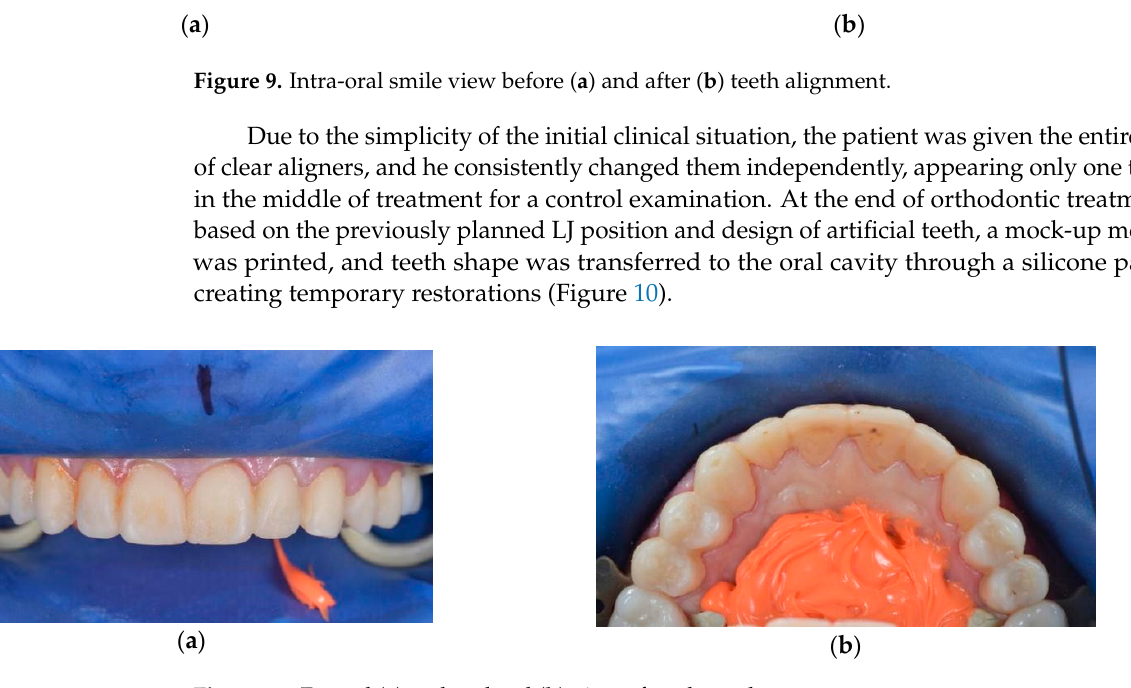
Figure 10. Frontal ( a ) and occlusal ( b ) view of teeth mock-up.